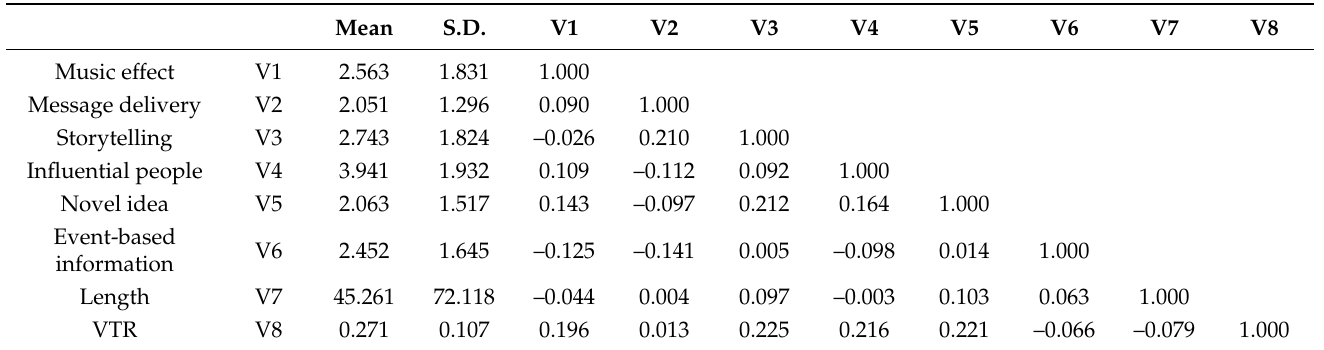
Table 4. Correlations Between